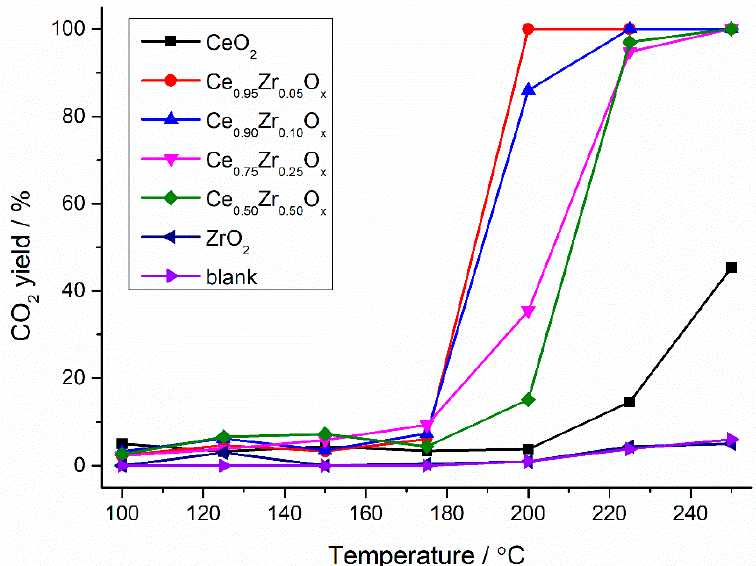
Figure 2. Catalytic activity for the total oxidation of naphthalene for the ceria–zirconia mixed metal oxide catalysts prepared using carbonate precursors. Reaction conditions: GHSV = 45,000 h -1 , 100 vppm naphthalene in 20% O 2 balanced with He. Legend refers to different Ce:Zr ratios.